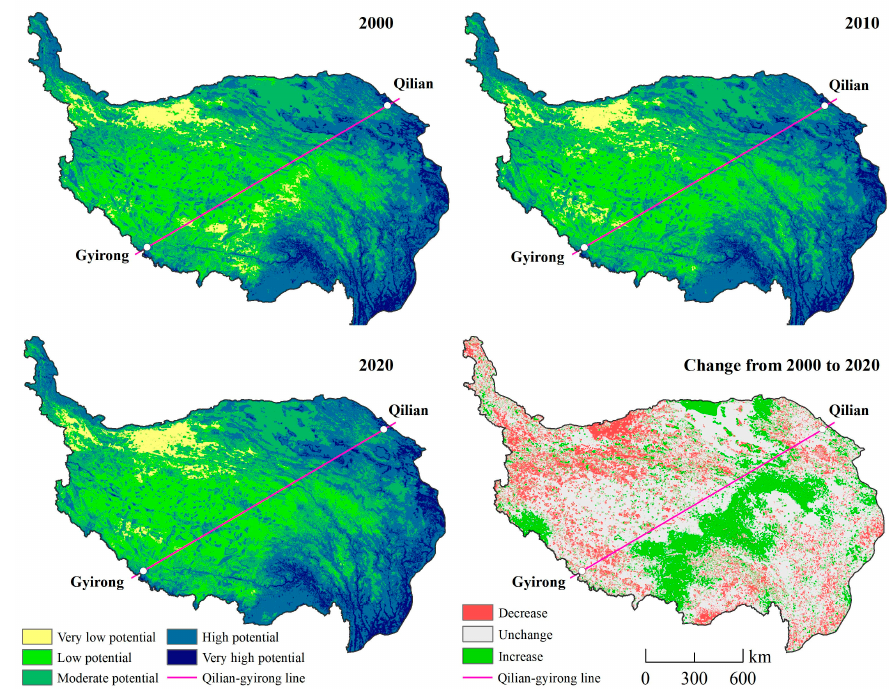
Figure 4. The spatial change in NBR from 2000 to 2020.